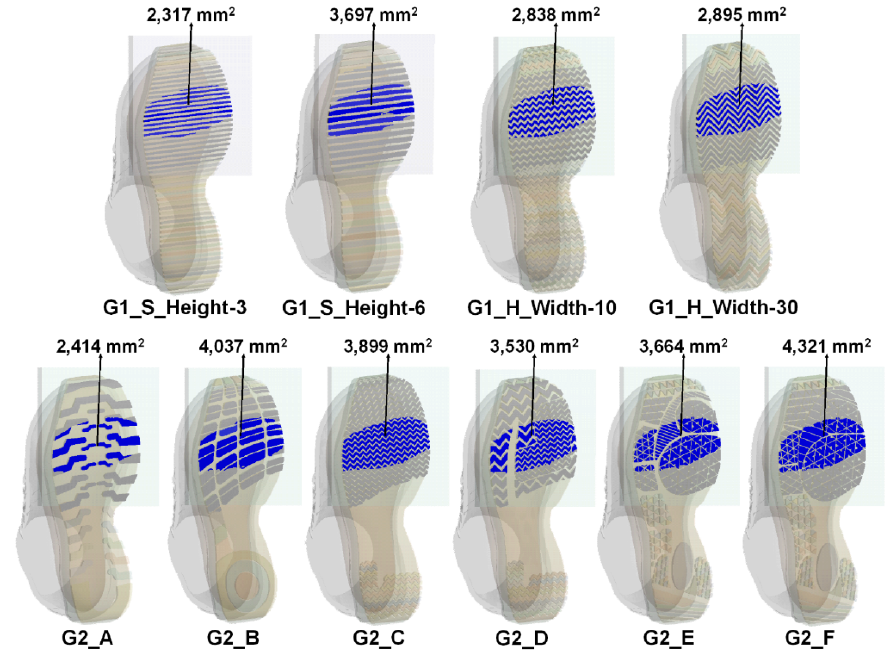
Figure 9. The predicted real contact area at push-off.